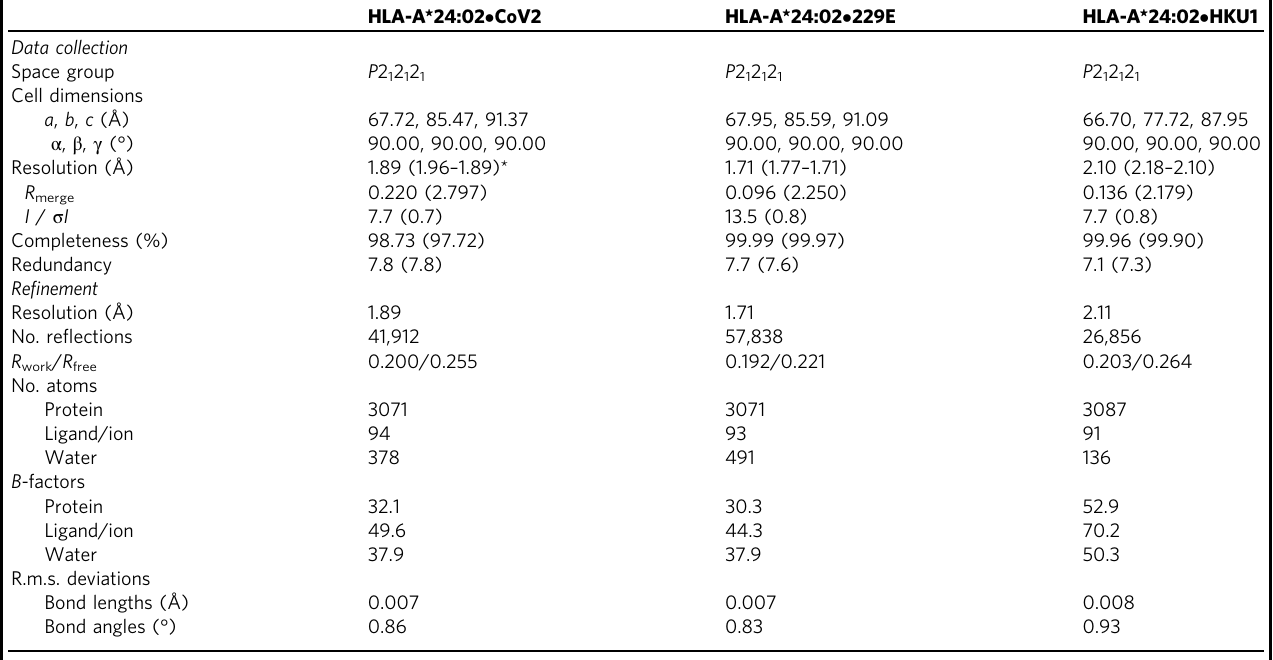
Table 1 Data collection and re fi nement